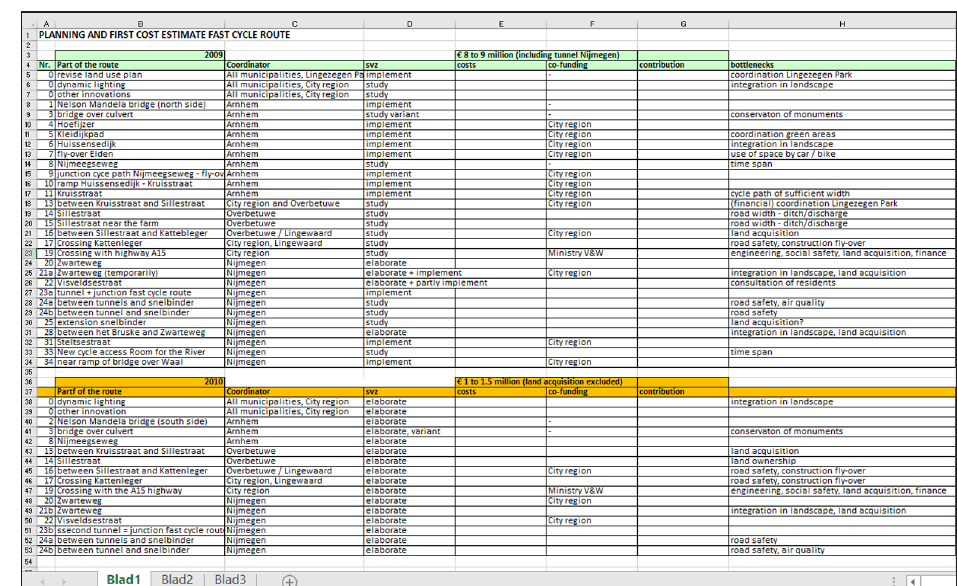
Figure 1: Exemplary SFR Budget spreadsheet. Source: Fiets Filevrij (2009), own